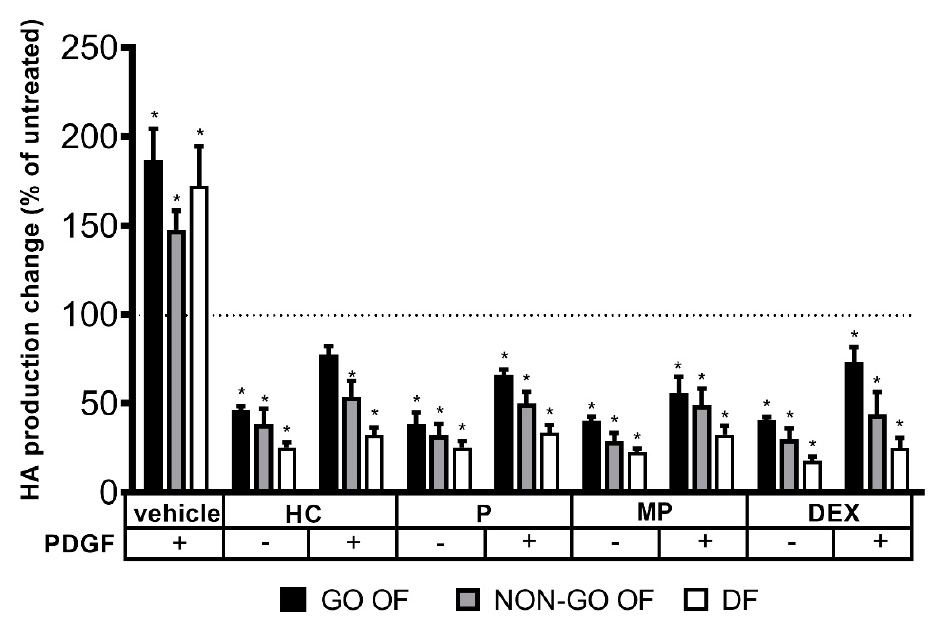
Figure 3. The influence of GCs (1 µ M) in the absence and presence of PDGF-BB on hyaluronan (HA) production. The dotted line represents the HA production of untreated cells. Data were analyzed using a repeated measures ANOVA followed by Dunnett’s test. Result shown are mean ± SEM. * p < 0.0001. GO OF—Graves’ orbitopathy fibroblasts, NON-GO OF—control orbital fibro ‐